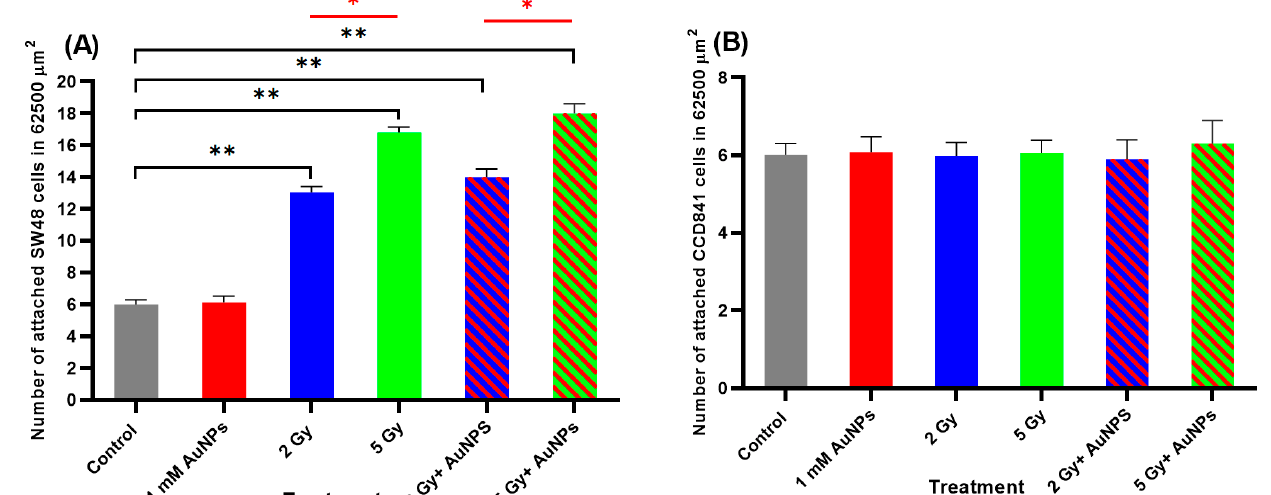
Figure 8. Effect of AuNPs and/or IR on the adhesion of A) SW48 and B) CCD841 cells in Vitro. Cells were treated with 1 mM AuNPs 24 h and/or 2 and 5 Gy (6 MV X-rays) and after 24 h the cells were trypsinised and plated in 6-well plates. After 4 h, the number of adhered cells in a 62,500 µm 2 area were counted. Results are expressed as the mean ± SEM of 3 replicates. Significance of different treatments compared to the untreated control is represented by black lines shown as ** p < 0.01 and red lines shown as * p < 0.05.